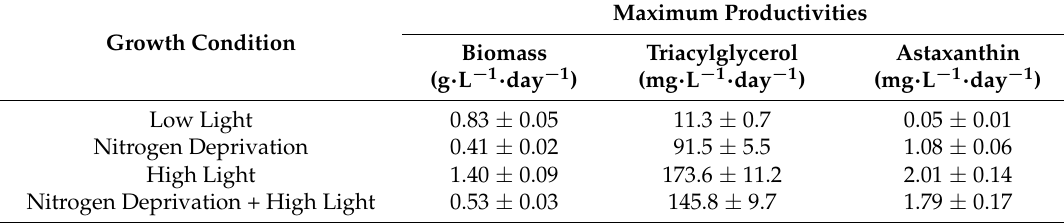
Table 3. Maximum productivities of biomass and key components for Chlorella zofingiensis . Adapted from